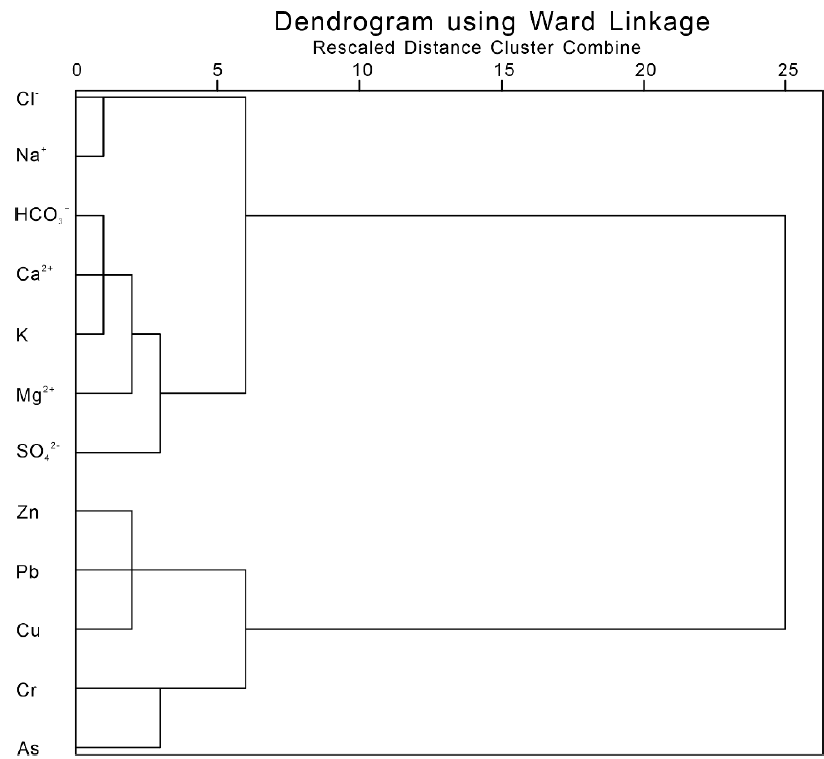
Figure 4. Hierarchical clustering analysis of major ionic and dissolved heavy metal elements in the river waters from Issyk − Kul Lake Basin during the period with low river flow.